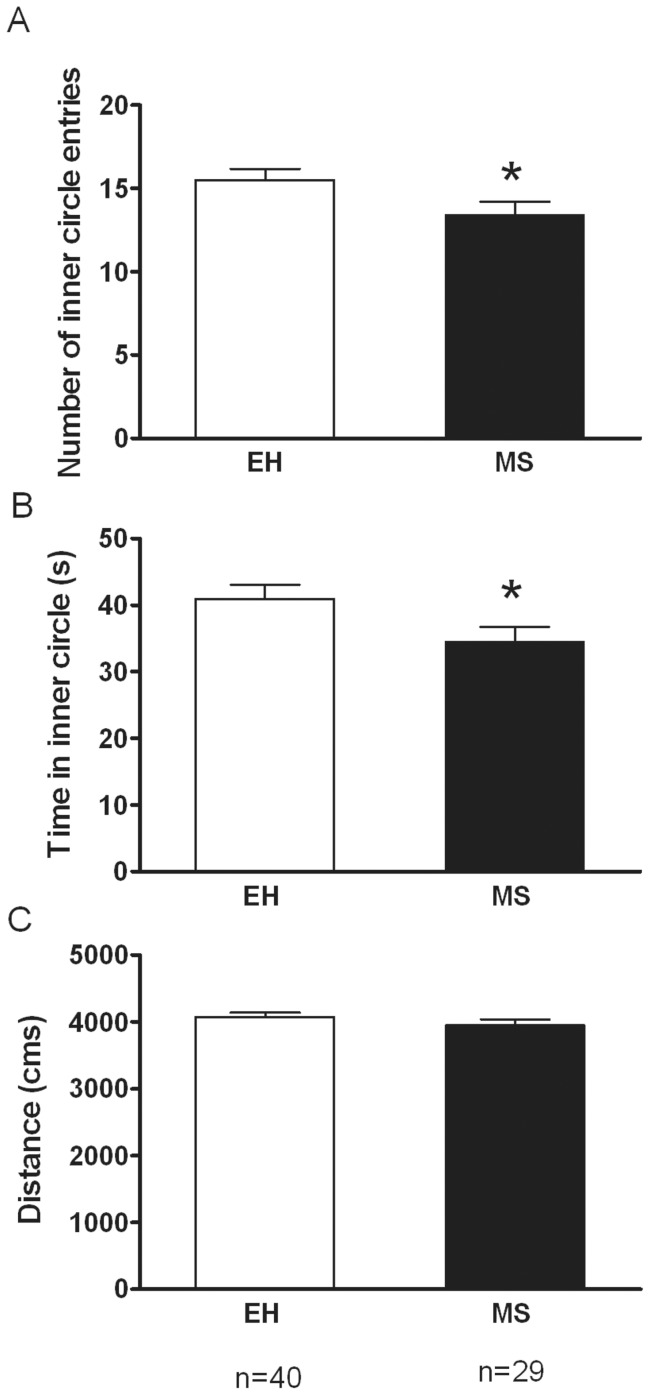
Effect of Maternal separation (MS) on anxiety-like behavior.Maternal separation (MS), increases anxiety-like behaviour on the open field test, compared to early handled (EH) controls. This was evidenced by significant reductions in (A) the number of inner circle entries (t test p = 0.04) and (B) the total time spent in inner circle (p = 0.04). No significant differences (p>0.05) were observed when comparing the total distance travelled (C). Data are expressed as Mean ± SEM.